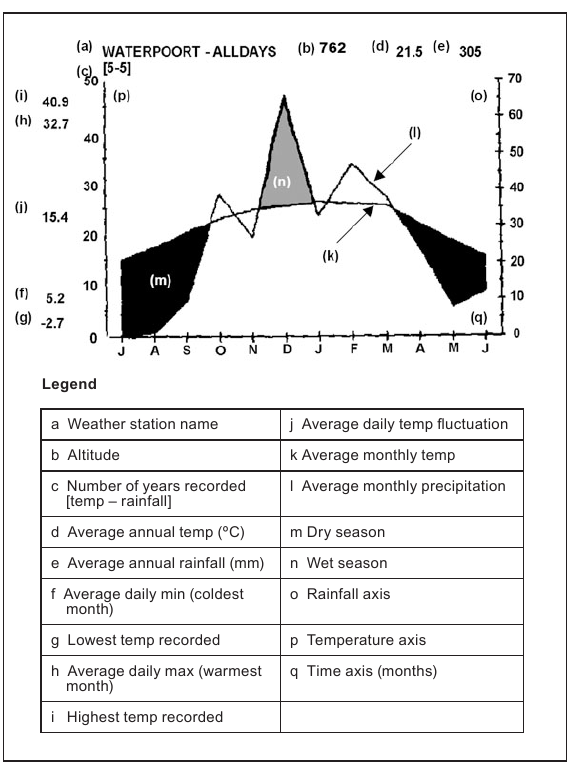
Figure 2 Climate diagram for the Alldays/Waterpoort